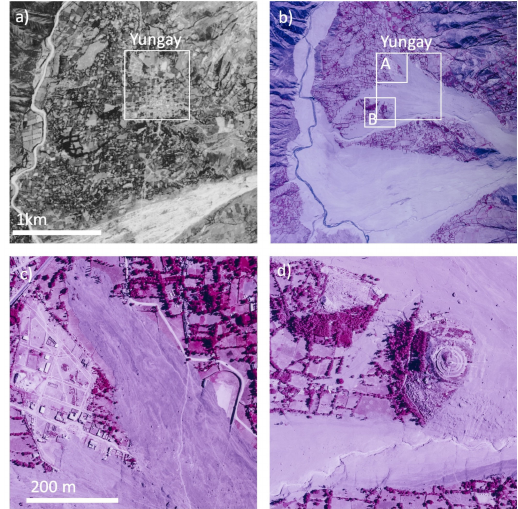
Figure 5. Yungay, Peru. The urban area before and after destruction by a landslide ( a ) 1966 (CORONA image) and ( b ) 1970 (Aerial image, near-infrared), with ( c ) (white box A in ( b )) details of debris covering road layout and city area and ( d ) (white box B in ( b )) round shape of elevated cemetery area saving people due to elevation (Data: Table